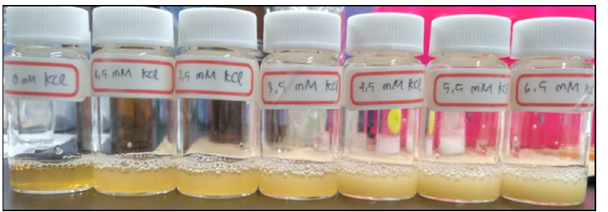
Figure 1. Turbidity of the treated blood plasma samples at different KCl concentration, in the presence of Na-TPB.